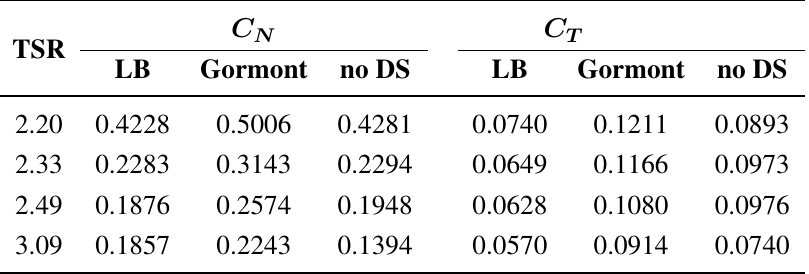
Table 1. The root mean square (RMS) of the difference between the predicted and measured results. LB, Leishman–Beddoes; DS, dynamic